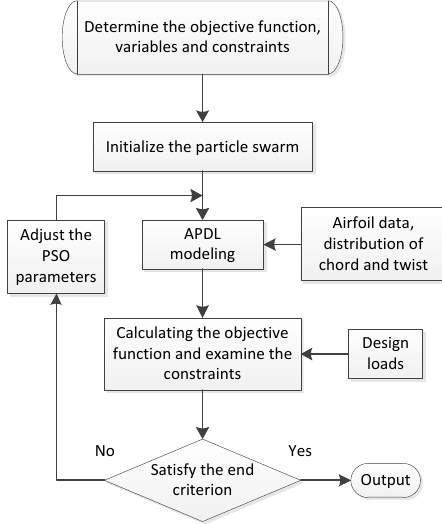
Figure 11. Flow chart of the structural design procedure.